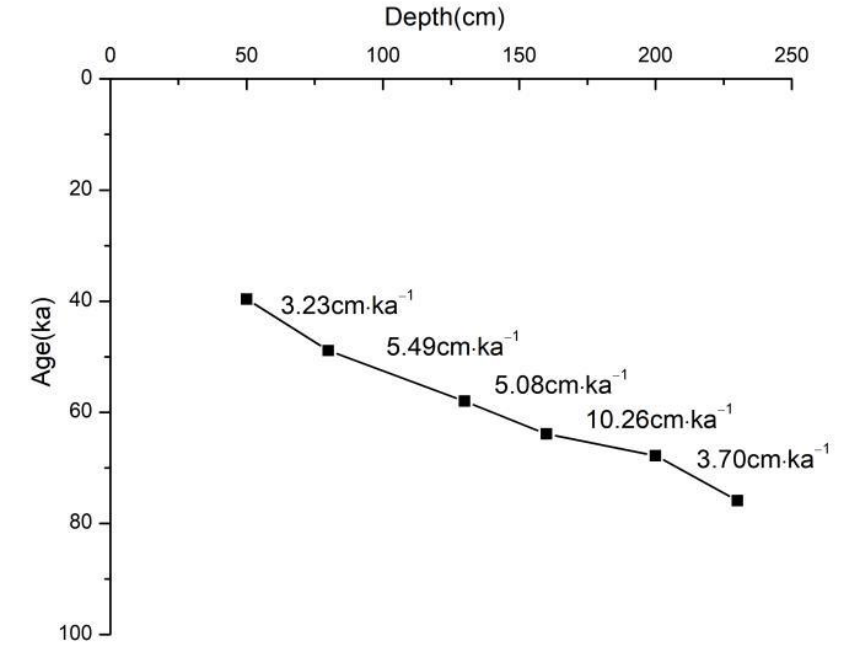
Figure 2. Age distribution of the CQS loess section.